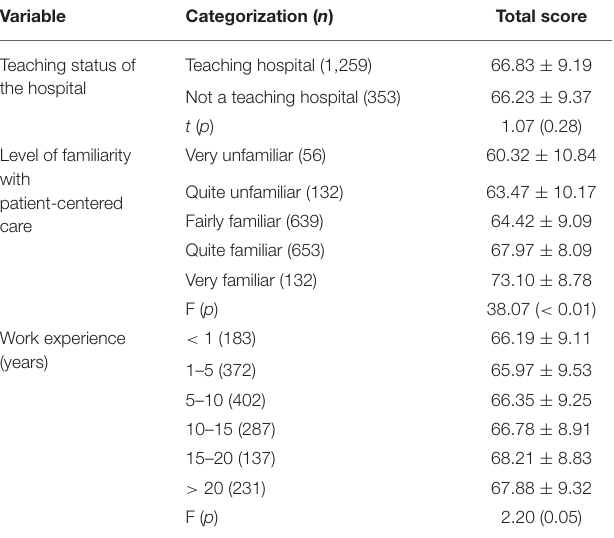
TABLE 2 | Comparison of healthcare workers’ mean scores on the provider-patient relationship questionnaire based on different demographic